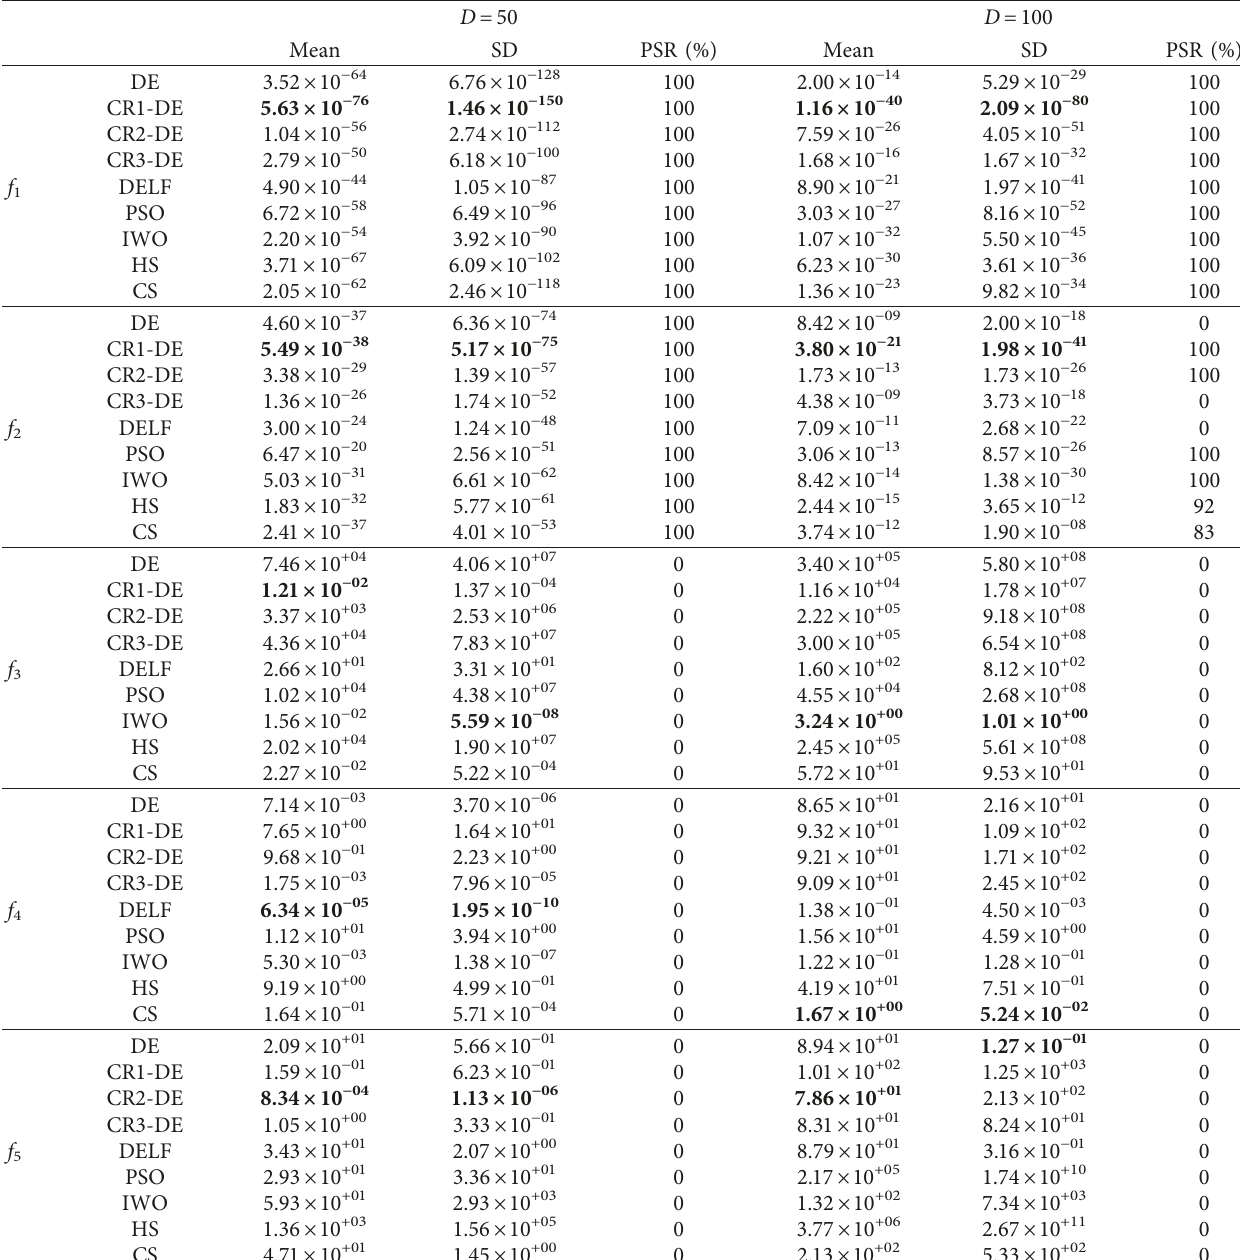
Table 3: Test results for ten benchmark functions at D � 50 and D � 100.